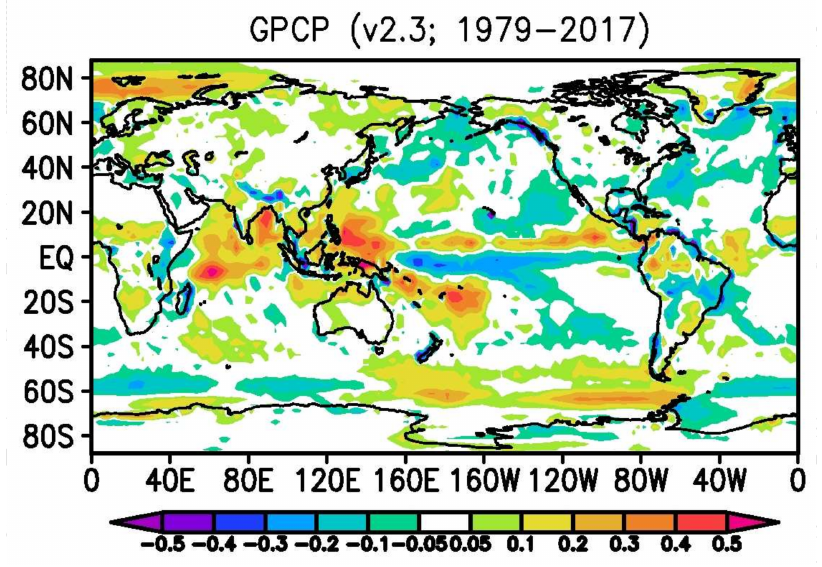
Figure 9. Linear trend of GPCP precipitation (mm day − 1 decade − 1 ) from